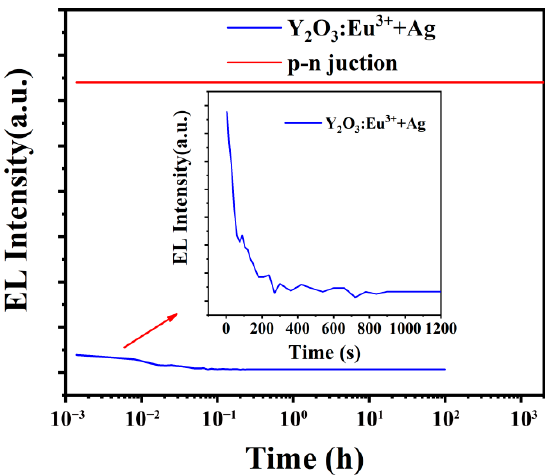
Figure 2. Luminescence intensity and lifetime test curves of p-n junction particles and rare earth oxide particles in red light wavelengths.